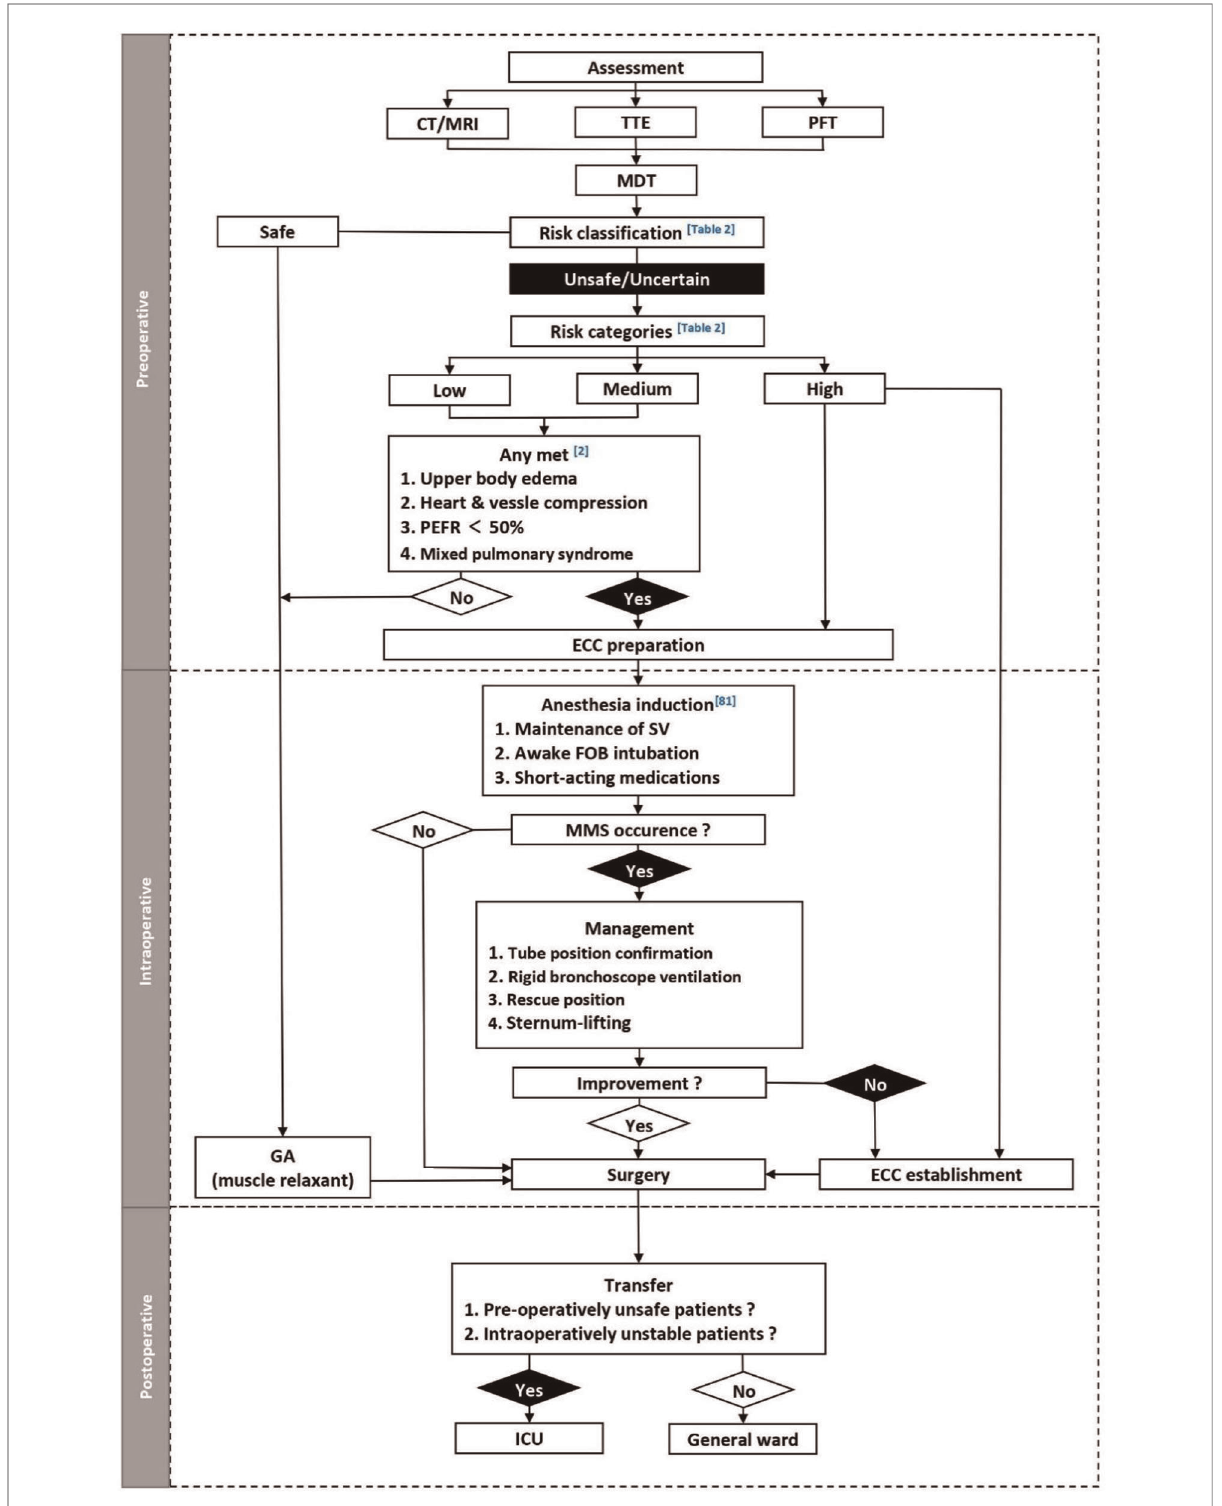
FIGURE 2 Perioperative management of patients with mediastinal mass. CT, computed tomography; ECC, extracorporeal circulation; FOB, fi ber optic bronchoscope; GA, general anesthesia; ICU, Intensive care unit; MDT, multidisciplinary team; MMS, mediastinal mass syndrome; PEFR, peak expiratory fl ow rate; PFT, pulmonary function testing; SV, spontaneous ventilation; TTE, transthoracic